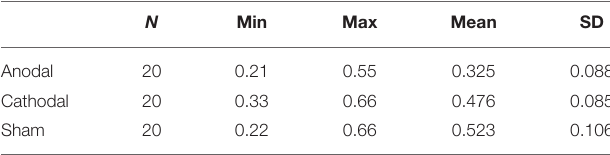
TABLE 1 | Mean (SD) Overbidding rates, as a function of stimulation condition, N 20 periods. =